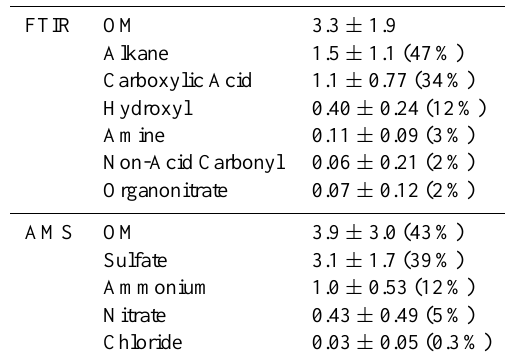
Table 1. Campaign average and standard deviation of FTIR- measured OM, FTIR organic functional group concentrations, and AMS-measured OM, sulfate, ammonium, nitrate, and chloride con- centrations in µgm − 3 . Functional group OM mass fractions (for FTIR) and component mass fractions of PM AMS (for AMS) are shown in the